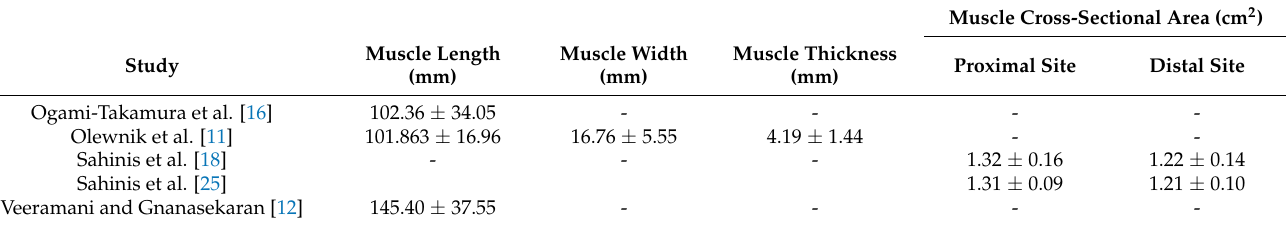
Table 4. Results of architectural data for the muscle belly of tensor of the vastus intermedius.